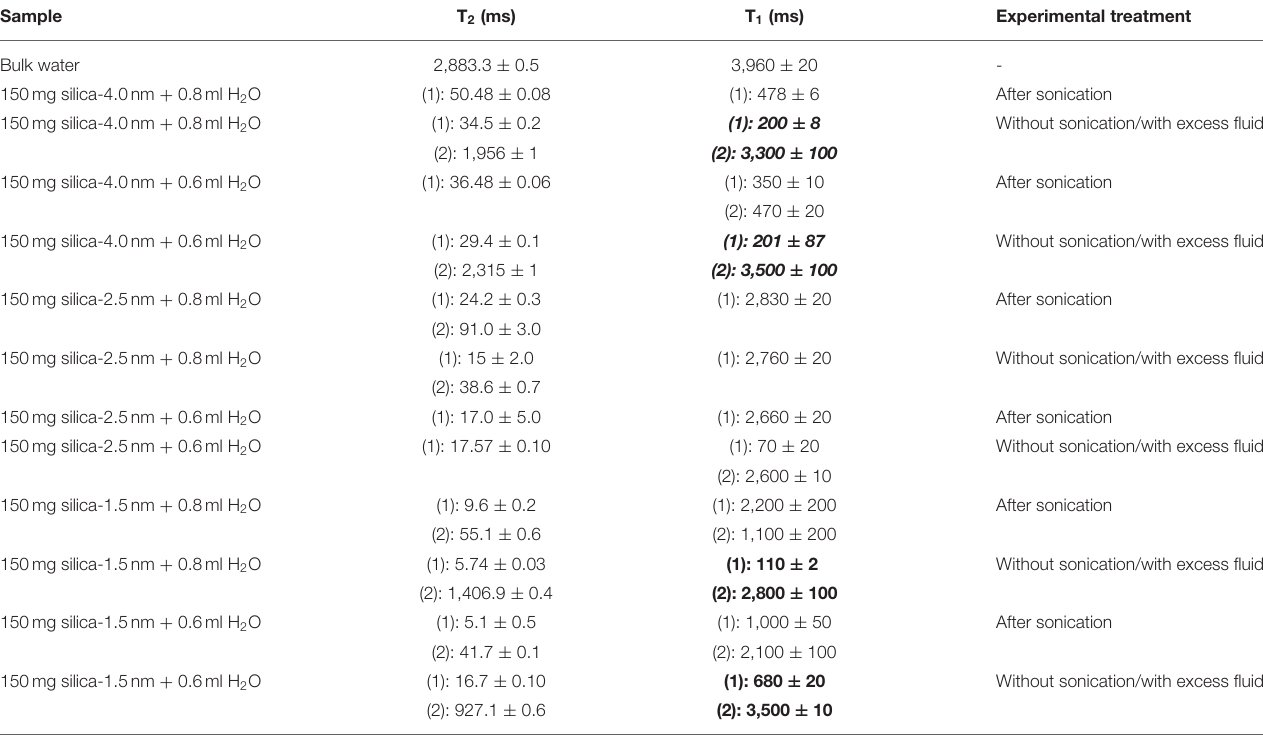
Bold and italic values are with excess fluid on top. In particular, T 1 (2) are the values closer to that of bulk fluid.